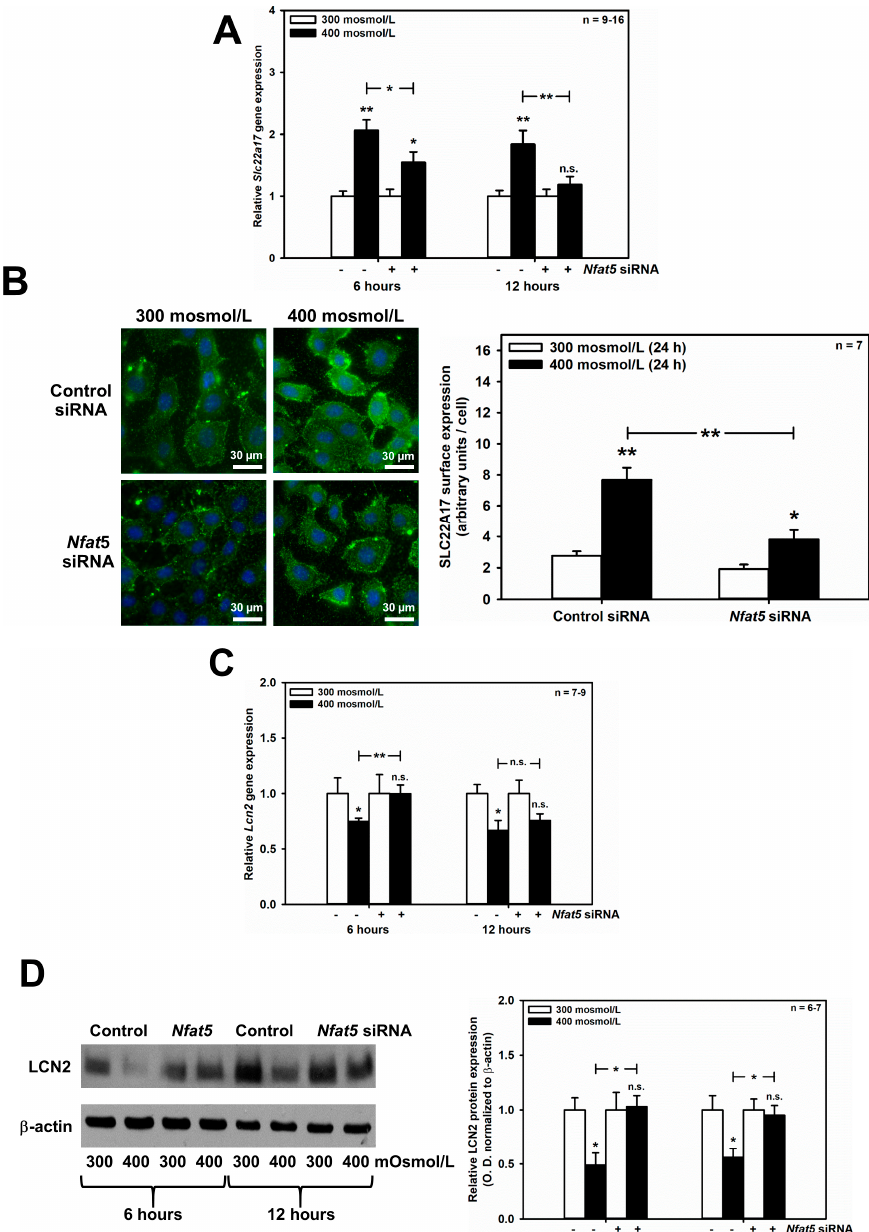
Figure 3. NFAT5 mediates the effects of hyperosmolarity on Slc22a17 /SLC22A17 and Lcn2 /LCN2 expression in mCCD(cl.1) cells. ( A , C ) mCCD(cl.1) cells were transfected with control or Nfat5